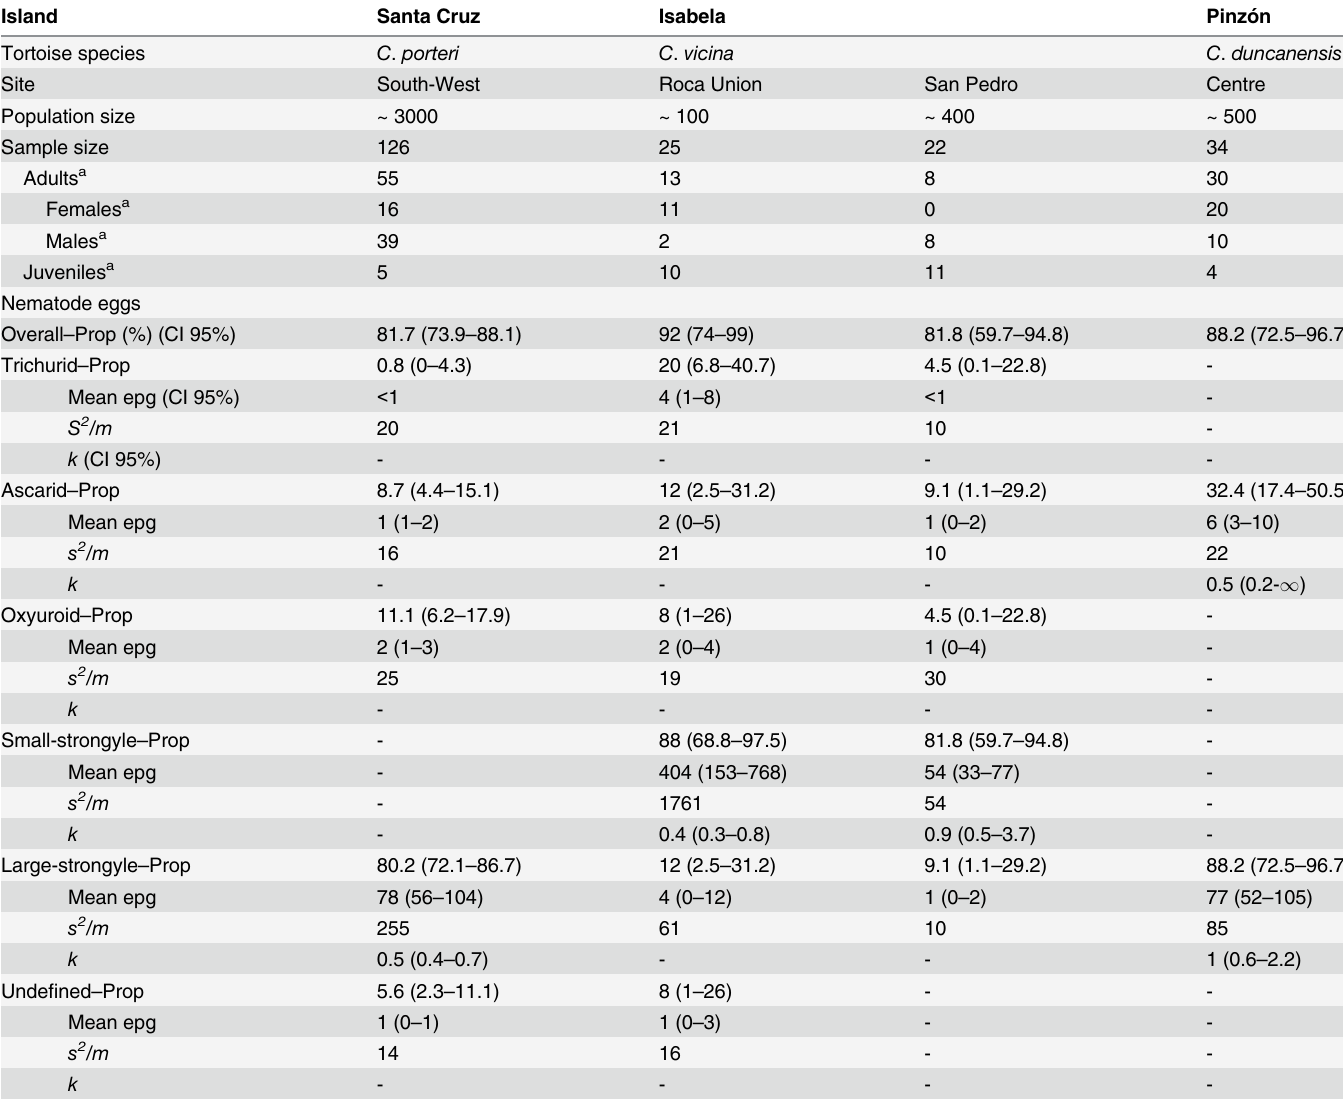
a. Age and sex were not available for all samples. Prop: proportion of parasitized tortoises. epg: number of nematode eggs counted per gram of faeces (CI 95%): 95% con fi dence interval for the proportion, the mean and the k parameter. k : parameter of overdispersion of negative binomial distribution. s 2 /m : variance to mean